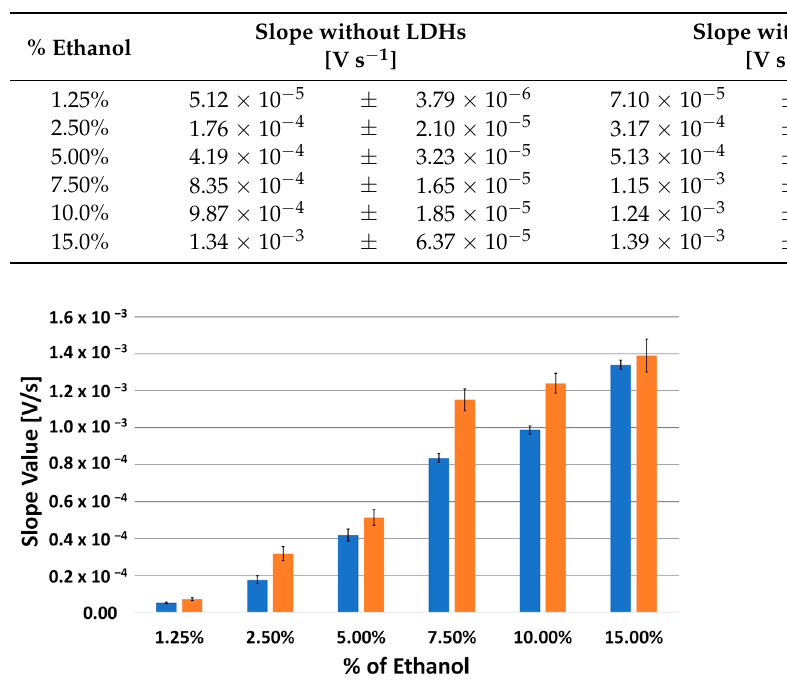
Table 1. Comparison of the slope values of the tangent line at the point of maximum slope to the obtained curves, without and with LDHs (63 mg), at the different percentages of hydroalcoholic solution used.